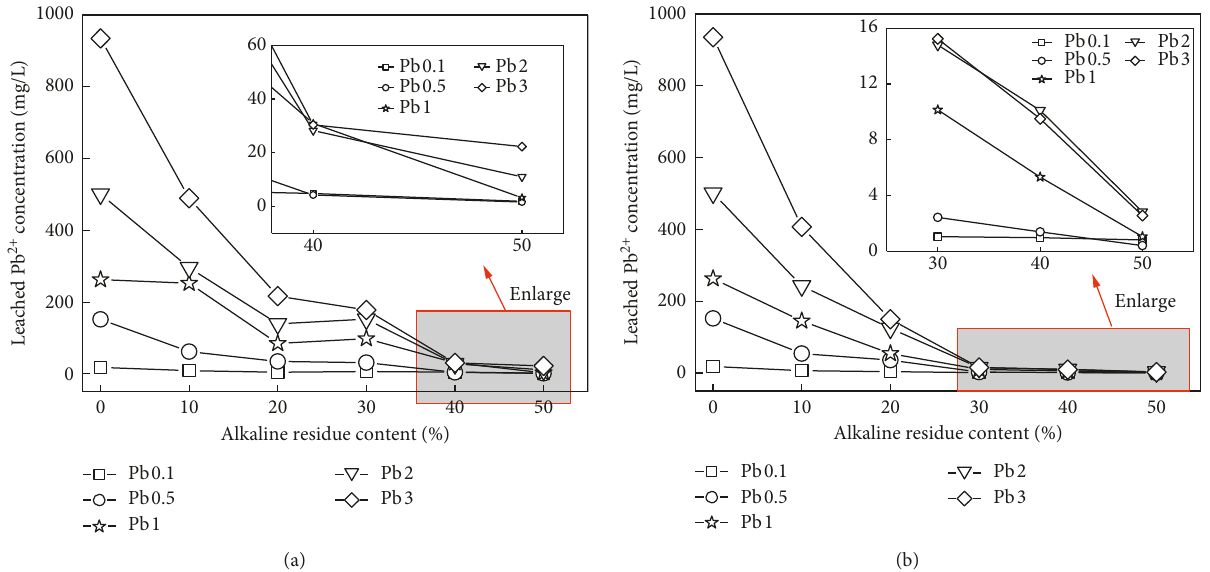
Figure 6: Evolutions of the leached Pb 2+ concentration with the alkaline residue content of the specimen. Curing times of (a) 1d and (b) 28